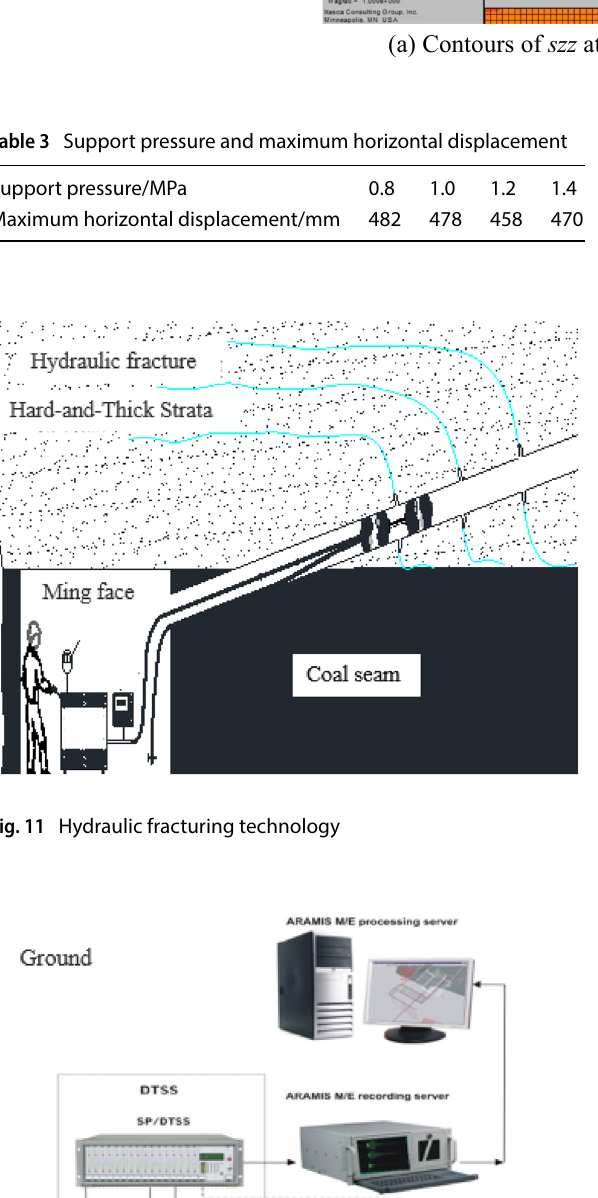
(b) Contours of szz at 130 m